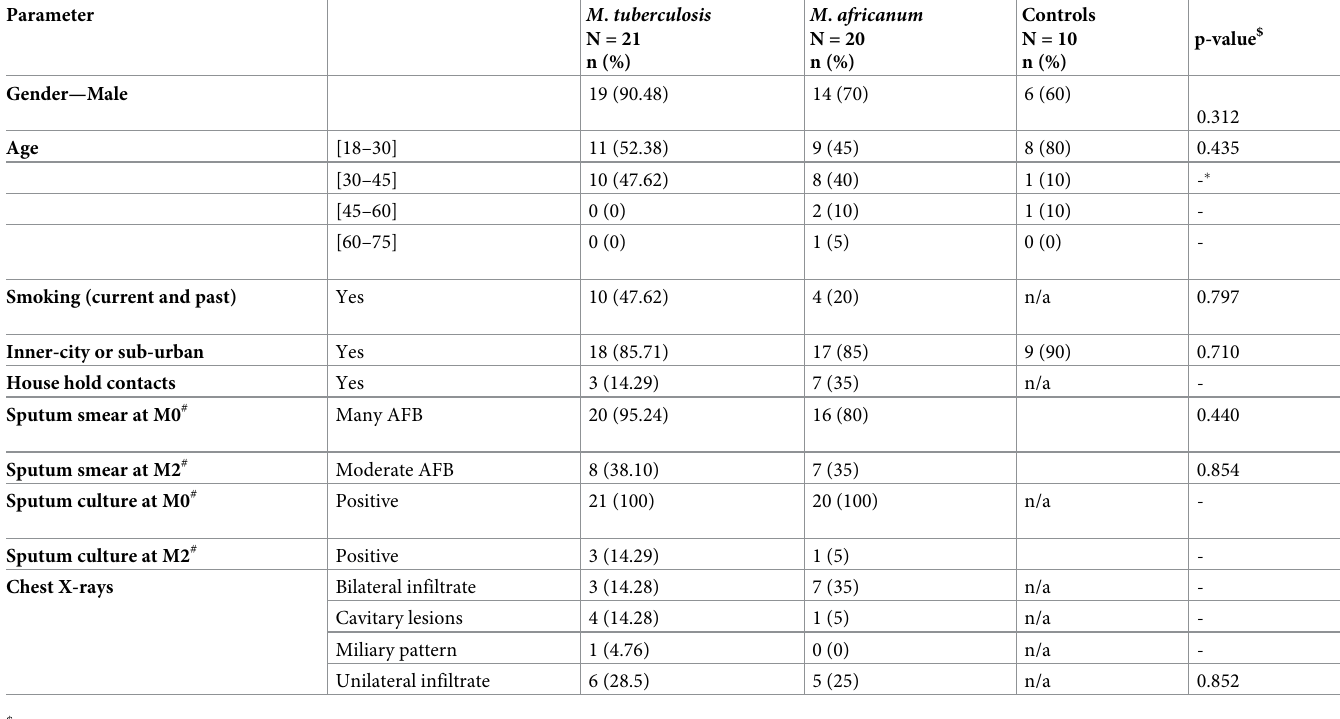
Table 1. Sociodemographic analysis of study participants.